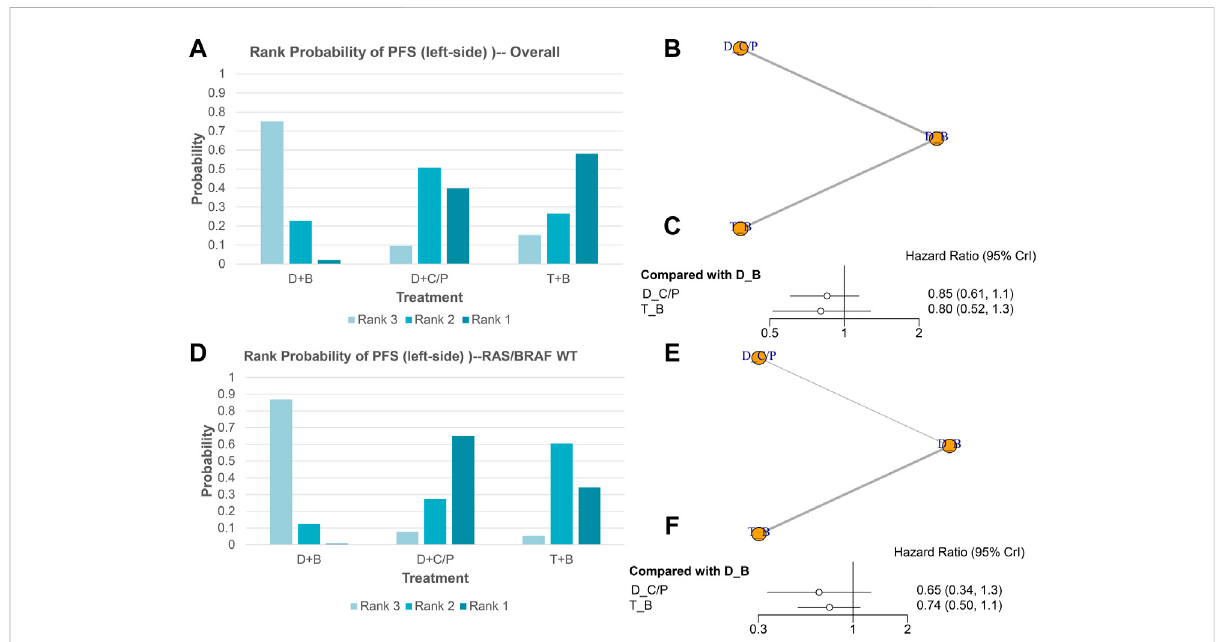
FIGURE 3 Progression-free survival (PFS) in overall and the subgroup of RAS/BRAF wild-type patients. Overall: (A) The rank probability of the bene fi ts of the treatments. (B) Network of eligible comparisons for network meta-analysis. (C) Forest plot of comparisons to double-drug regimen plus bevacizumab. RAS/BRAF WT: (D) The rank probability of the bene fi ts of the treatments. (E) Network of eligible comparisons for network meta- analysis. (F) Forest plot of comparisons to double-drug regimen plus bevacizumab. (N = 1925, B: bevacizumab; C: cetuximab; D: double-drug; P: panitumumab; T: